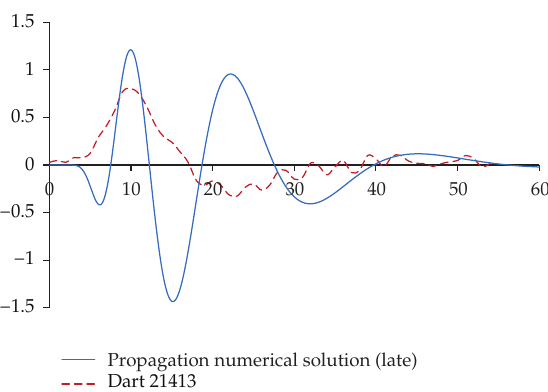
Figure 5: DART 21413: Data showing tsunami about 90 minutes after the earthquake and propagation model.